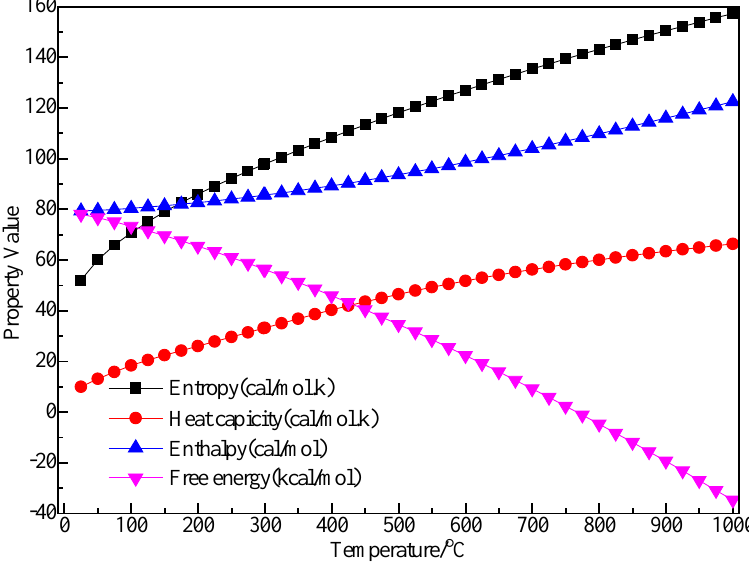
Figure 5 . The relationship between the thermodynamic properties of (C 2 H 5 ) 2 AlBr and temperature.